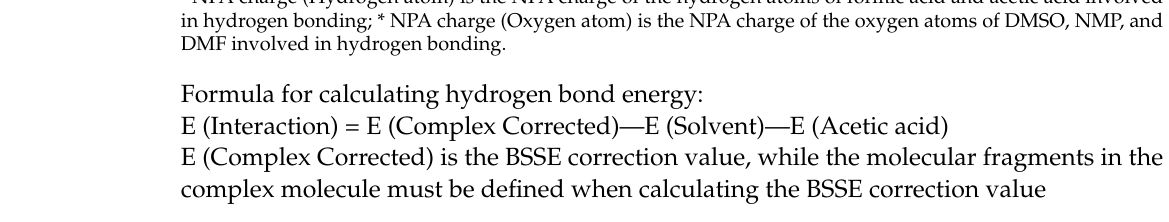
Figure 6. Schematic diagram of the hydrogen bond length formed by acetic acid and three solvent molecules, and the NPA charge of each atom.